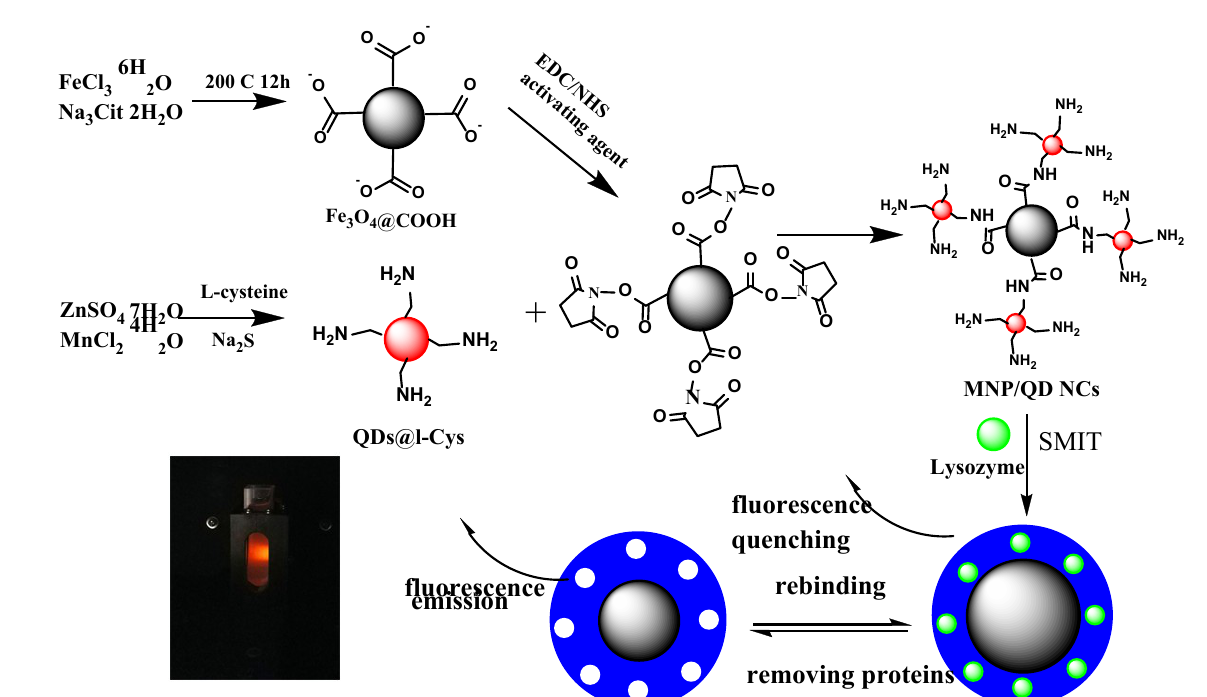
Figure 1. Schematic of the synthesis of MNP/QD@MIP-based sensor. SMIT: surface molecularly imprinting technology.